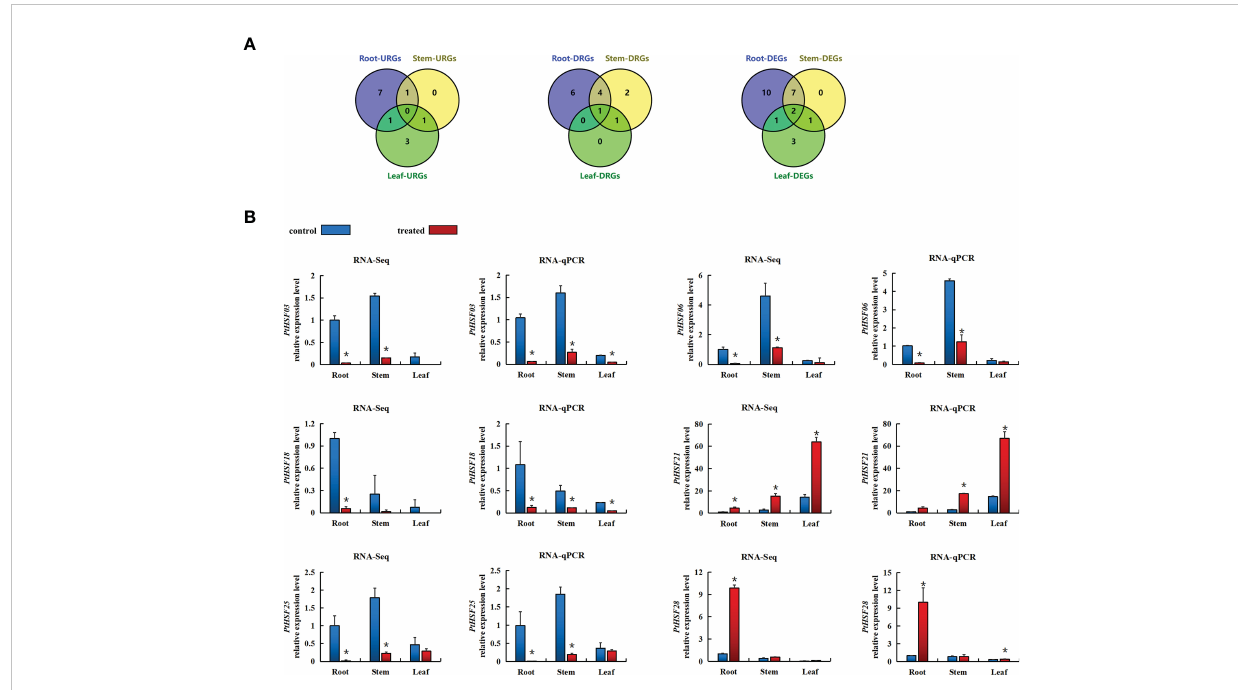
FIGURE 6 (A) VENN diagram of differential gene expression in the roots, stems, and leaves of poplar after salt stress. The fi gure indicates the number of DEGs in response to salt stress in different tissues, upregulating the number of DEGs and downregulating the number of DEGs. DEG means differentially expressed gene, URG means represent upregulating differentially expressed gene, and DRG means represent downregulating differentially expressed gene. (B) After salt stress, the expression pattern of the HSF gene in different poplar tissues was based on RNA-Seq and RT-qPCR analysis. Blue indicates the control group, and red indicates the salt treatment. Based on the expression level of corresponding genes in the roots of the control treatment, the relative expression level of each gene under salt stress was calculated. The error line represents the standard deviation (SD) of biological replication. “ * ” indicates there is a signi fi cant difference (P <0.05).